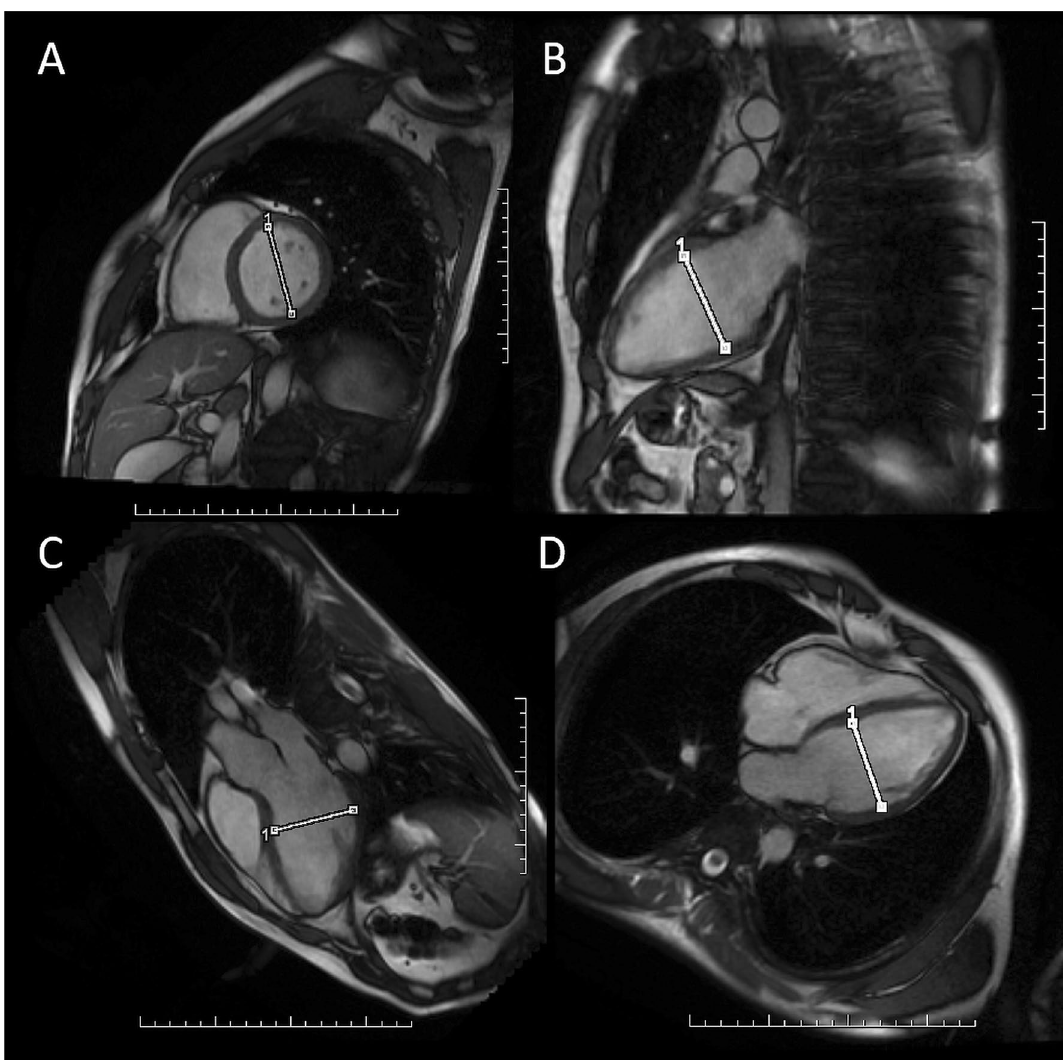
Figure 1. The method of measuring the left ventricular end-diastolic diameter in CMR: ( A ) in the short axis, ( B ) in the long axis in the 2-chamber view, ( C ) in the long axis in the 3-chamber view, ( D ) in the long axis in the 4-chamber